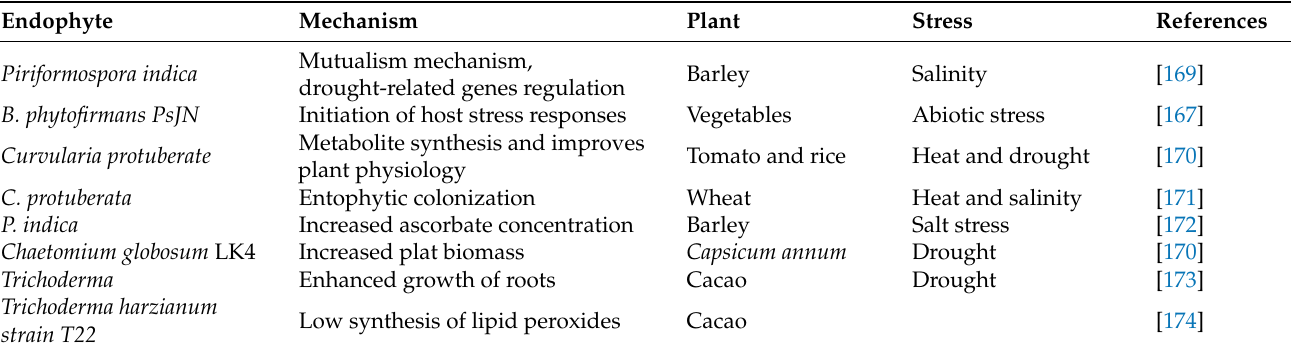
Table 2. Endophyte mechanism for plant-growth promotion under abiotic